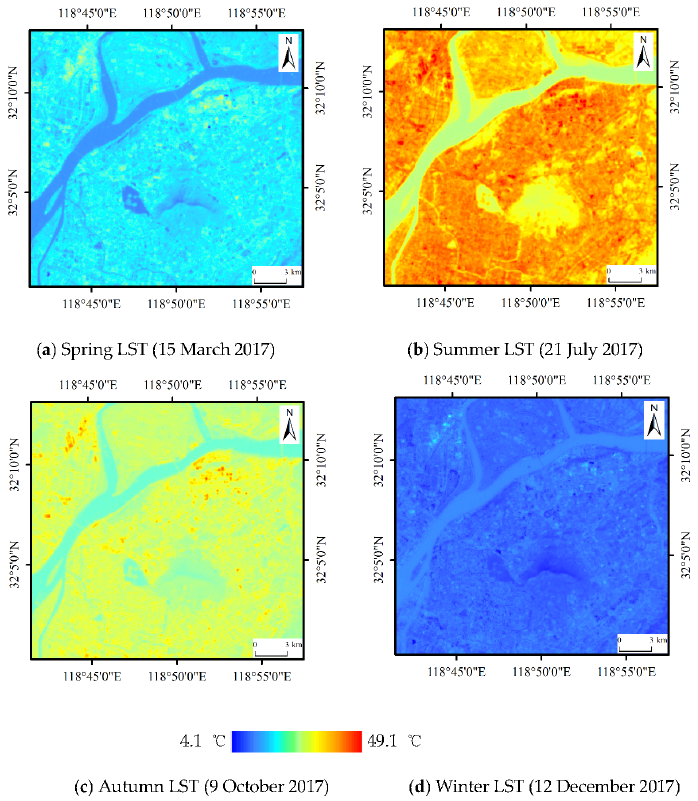
Figure 2. The land surface temperature (LST) retrieved from the four seasons’ Landsat 8 data; spring, summer, autumn, and winter images were acquired on 15 March, 21 July, 9 October, and 12 December 2017, respectively.